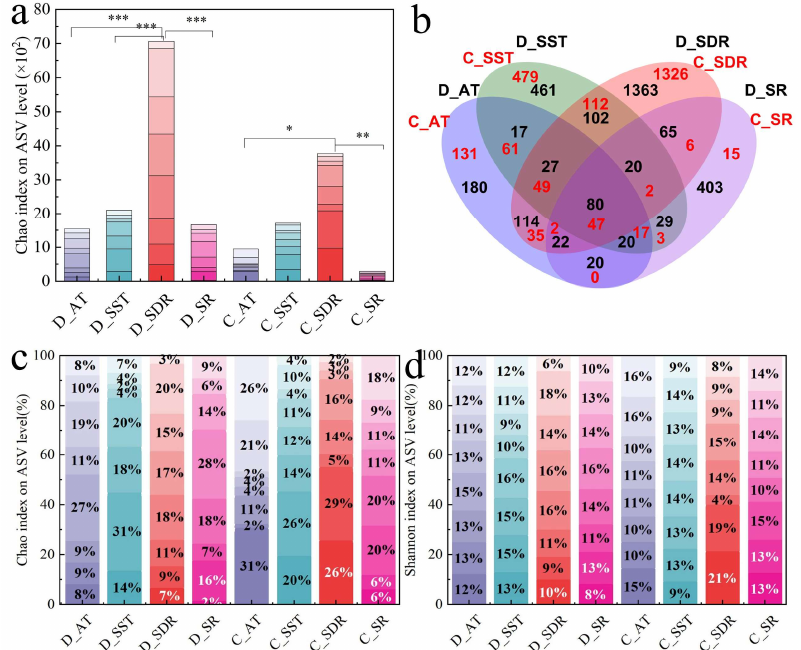
Figure 2. Size distributions at different sampling sites. ( a ) Chao indices in Plant C and Plant D. ( b ) Venn diagram based on ASVs, black font for Plant C and red font for Plant D. ( c , d ) Proportion of Chao and Shannon indices at each size stage. AT: aeration tank; SST: secondary settling tank; SDR: sludge dewatering room; and SR: screen room. Stage Ⅰ – Ⅷ: color from dark to light; * significance at 0.05 probability level, ** significance at 0.01 probability level, *** significance at 0.001 probability level.